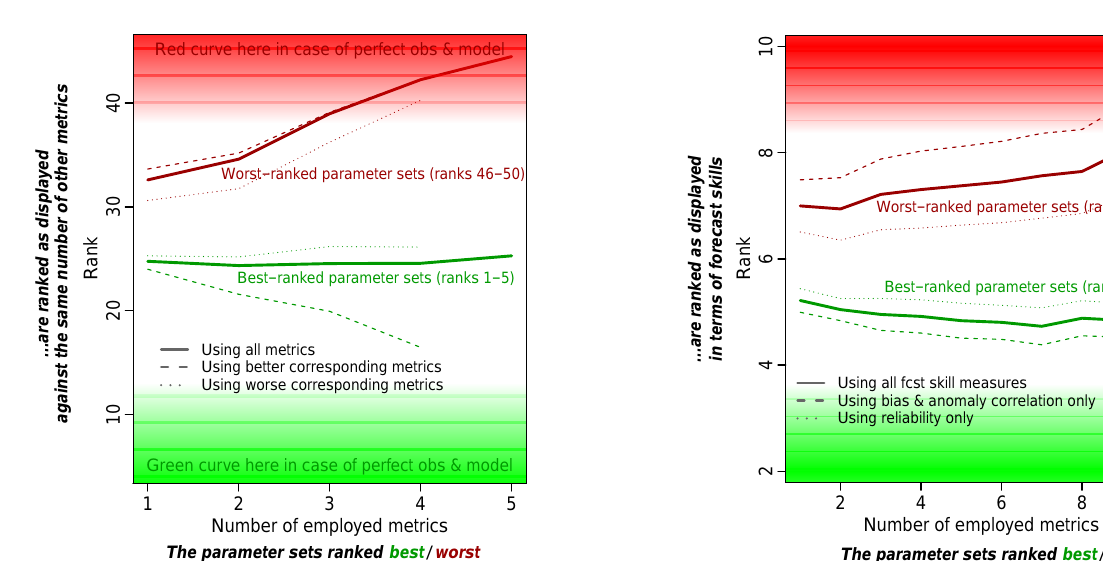
The parameter sets ranked best worst / against this number of metrics... Figure 4. Comparing the rankings of HTESSEL simulations with Figure 5. Similar to Fig. 4 but comparing the performance (ranking) all considered parameter sets when replacing a given set of evalua- of HTESSEL simulations with 11 parameter sets across uncoupled tion metrics with an equal number of other metrics. The red curve evaluation ( x axis) and coupled forecast skills ( y displays the average rank of the previously worst-ranked parameter sets, and the green curve denotes the average rank of the previously best-ranked parameter sets. For each number of metrics, all possi- ble combinations out of the 10 metrics employed in this study are considered, and the mean results are displayed.